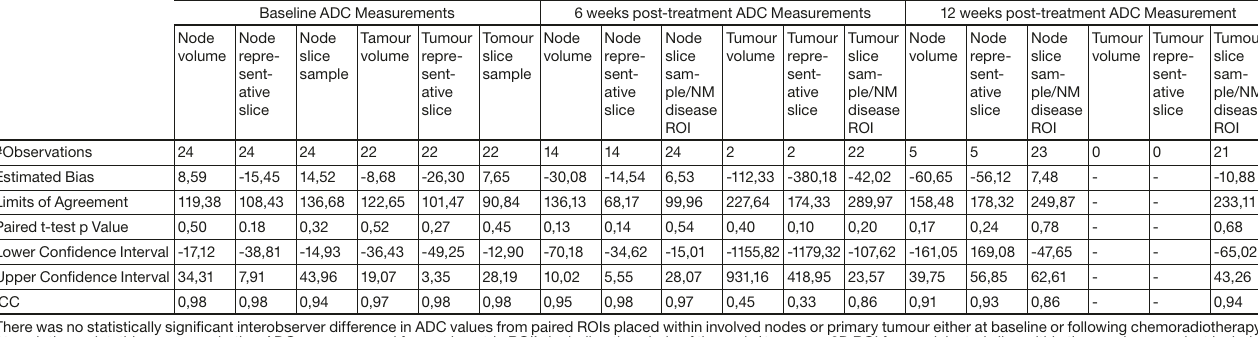
Table 2: Change in ADC measurements between baseline and 12 weeks post-treatment